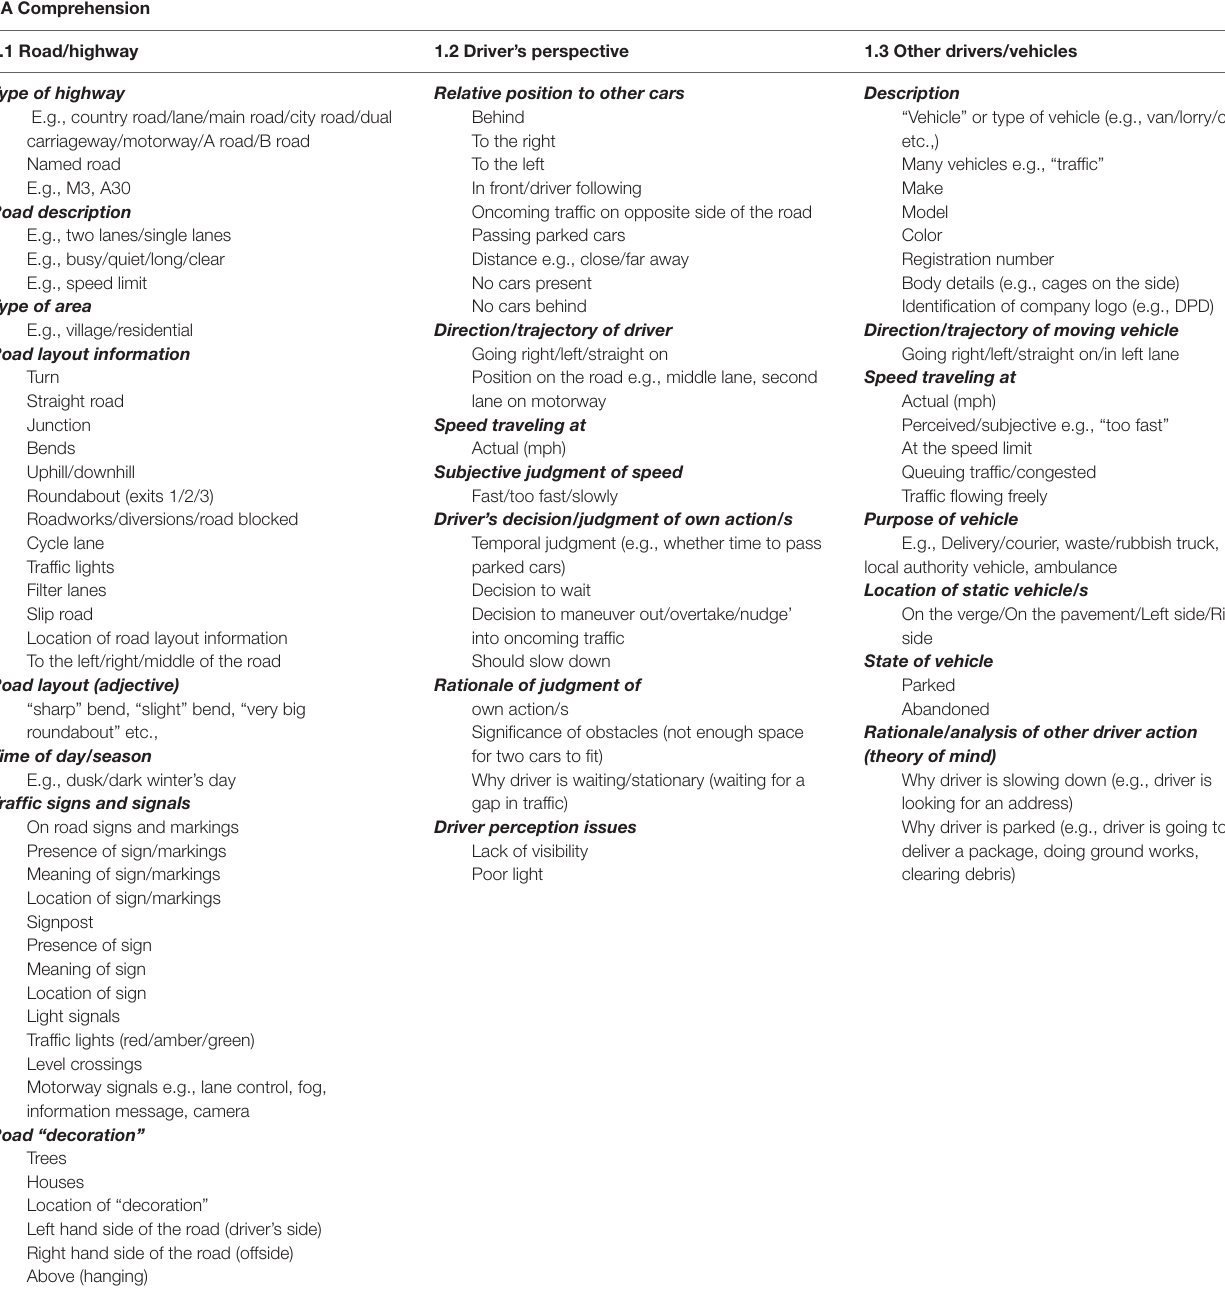
TABLE 3 | Taxonomy of situation awareness in video-relays of driving scenes for SA Comprehension and SA Prediction. SA